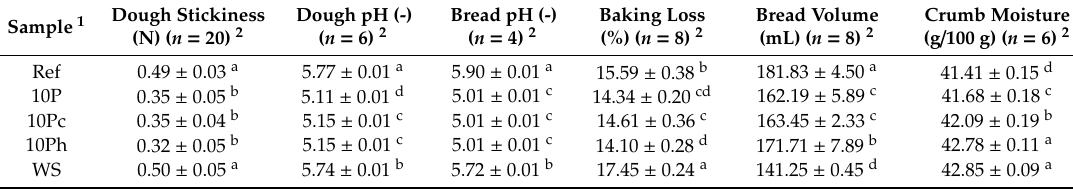
Table 2. Dough and bread